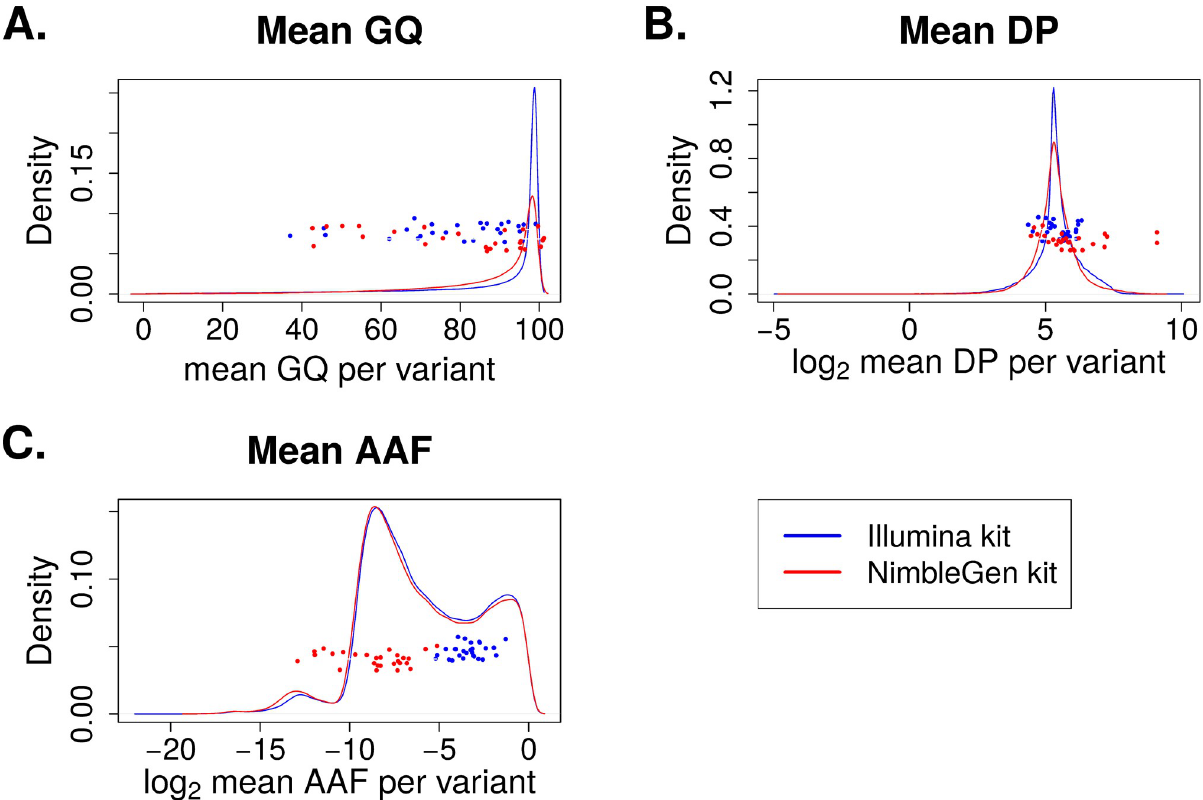
Fig 4. Density plots of variant quality parameters between two exome capture kits. Mean values were computed across all samples for each variant. The solid lines show the distributions of all 166,947 variants used in the association analyses, and the scattered dots represent the 29 novel SNPs. (A) Density plot for mean genotype quality (GQ). (B) Density plot for mean read depth (DP). (C) Density plot for mean alternative allele fraction